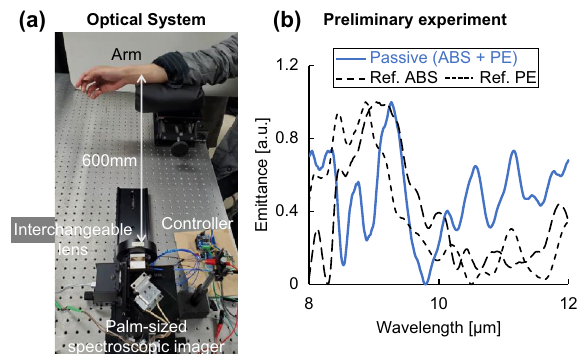
Figure 1. Optical system of mid-infrared passive spectroscopic imaging using subject A’s wrist and back of the hand as measurement sites. (a) The optical system. (b) Preliminary experimental results using plastic (8-mm ABS plate and 1.20-mm PE thin film). The spectrum in ( b ) was normalized from 0 to